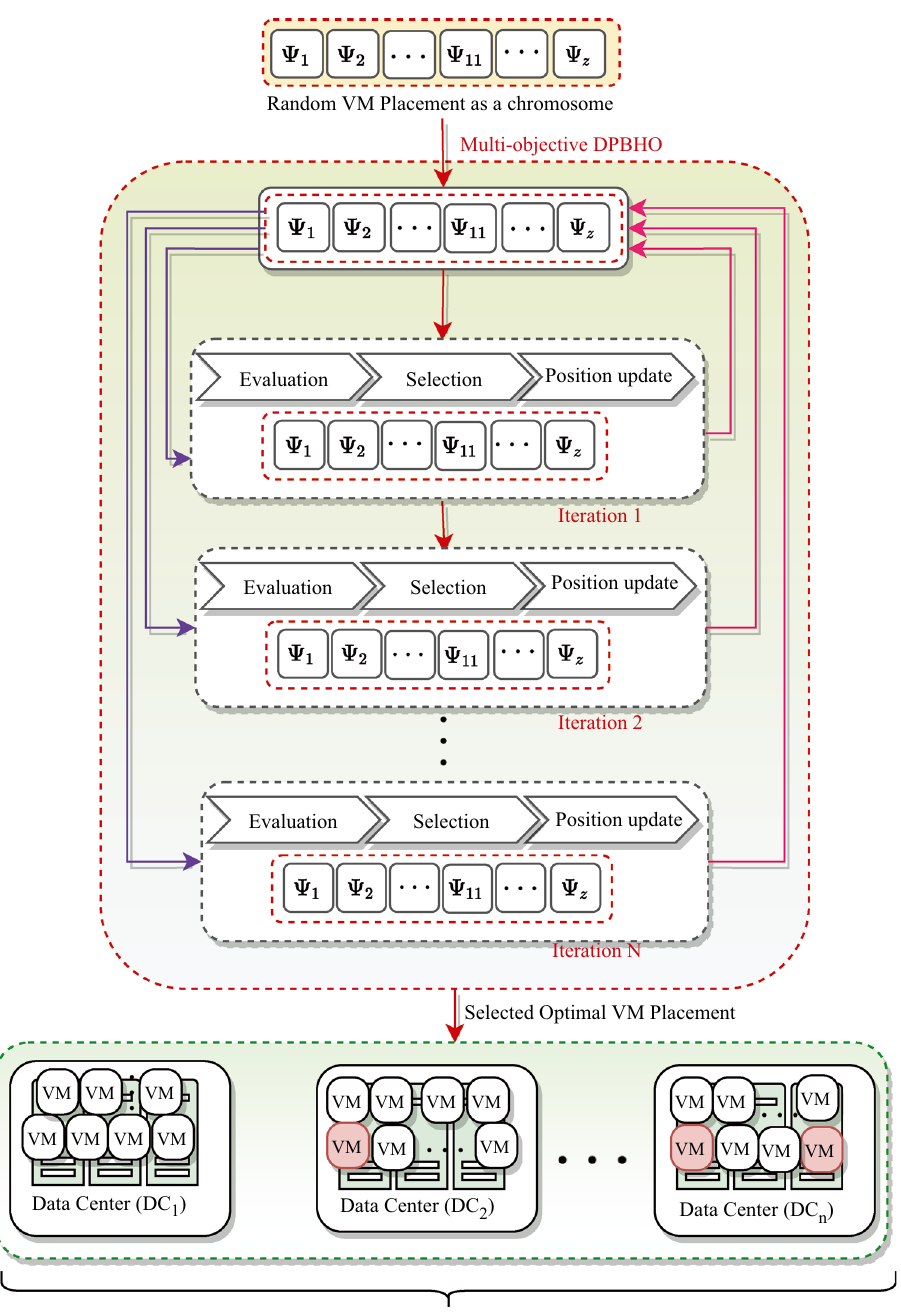
Figure 9. Multi-objective DPBHO based VM